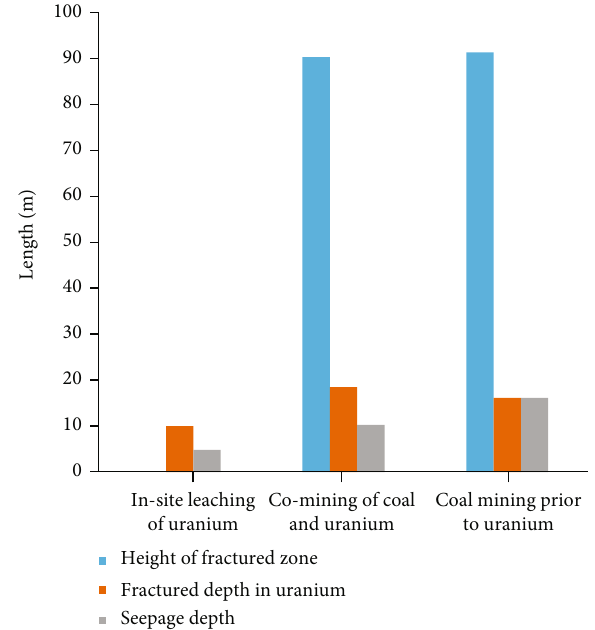
Figure 9: Comparison in the development of fracture and seepage for coordinated mining of coal and